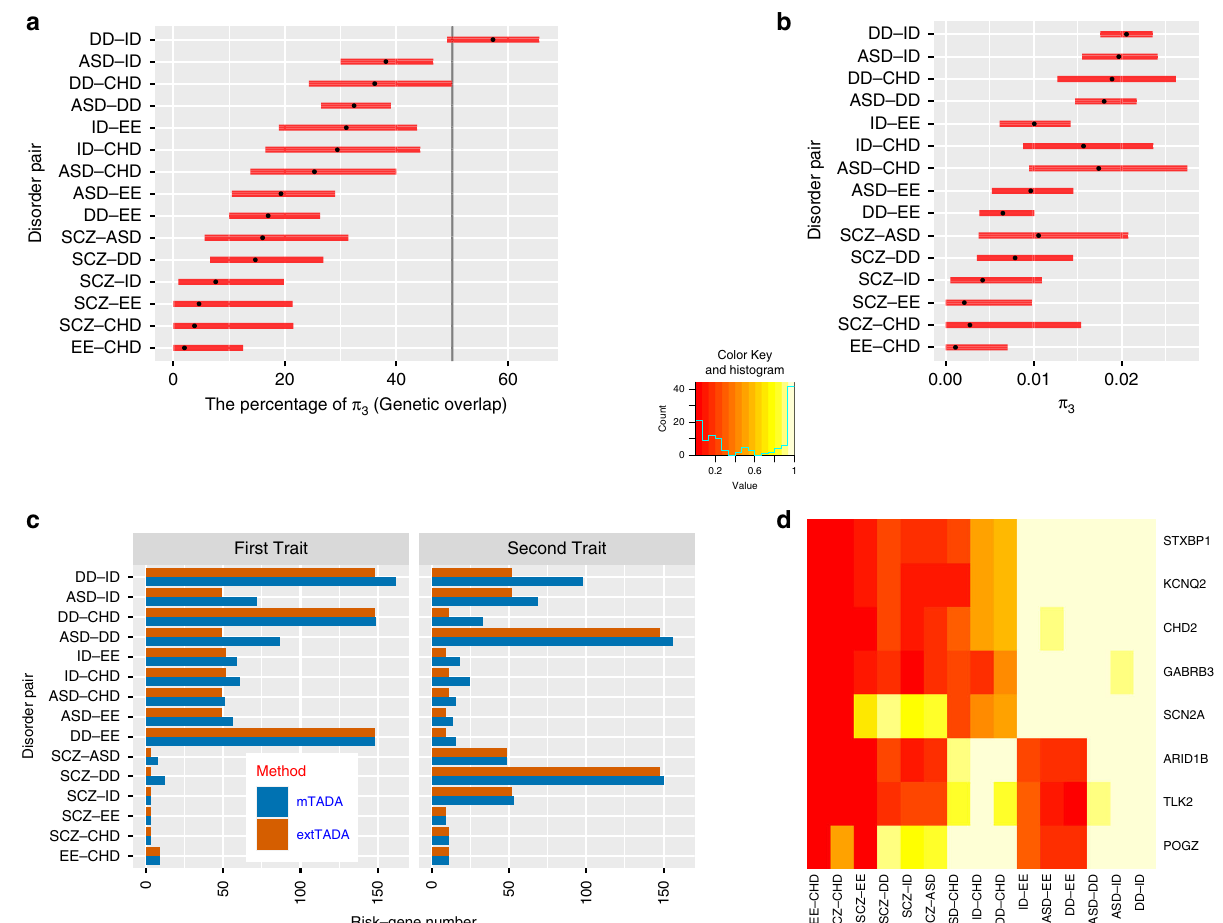
Fig. 4 Analysis results of mTADA for pairs of disorders. a The estimated gene-level genetic overlaps (gOs) of pairs of disorders from Markov Chain Monte Carlo sampling results. Each par shows the credible interval and the black dot is the estimated value. The vertical black line describes g0 = 50%. b The estimated proportion of overlapping risk genes ( π 3 ) in the mTADA model. c Comparison of mTADA and extTADA in the prioritization of top genes by using a threshold of posterior probability (PP) > 0.8. In mTADA, the column ‘ First trait ’ and ‘ Second trait ’ are inferred by summing the PPs of model 1 and 3 (PP1 + PP3), and model 2 and model 3 (PP2 + PP3) in Fig. 1 respectively. d These genes appear in at least 4 pairs of disorders (PP > 0.8). Cells show the PP values. Y -axis shows gene names and x -axis describes pairs of